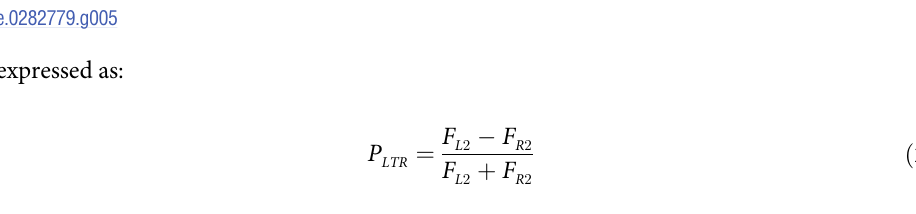
Fig 5. Force model of the vehicle. Note: F N; F g the centrifugal force exerted on the vehicle, N; θ the cross-slope angle of the road, ˚; P the vehicle center of mass; h the height of the vehicle centroid, m; and t the axle track, m.